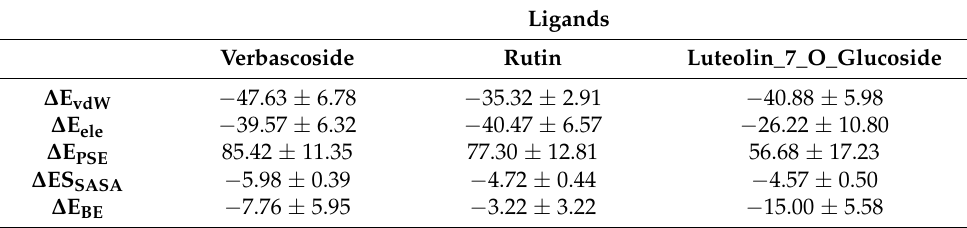
Table 6. Binding free energy of ligands with PKM2 calculated by the MM-PBSA method for 100 snapshots of MD simulation.